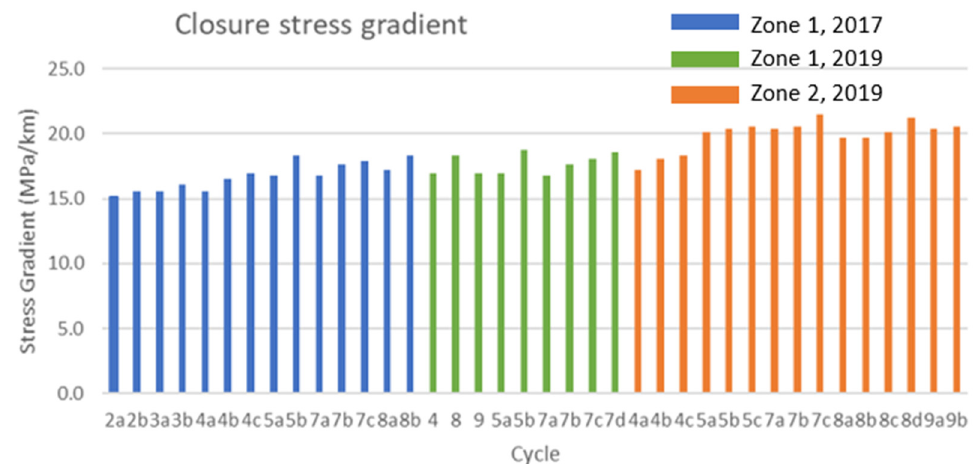
Figure 15. Summary of closure stress gradient in di ff erent zones. Zone 1 gradients range from is 15.2–18.8 MPa / km (average 17.2 MPa / km). Zone 2 gradients range from 17.2–21.5 MPa / km (average 19.9 MPa / km). With the monotonically increasing values in Zone 2, taking the average value is not necessarily reasonable, suggesting an underlying physical mechanism. Note that each cycle may have multiple interpretations by di ff erent methods labeled as a, b, c, and d, respectively (refer to Tables A1–A3 for the specific method used).